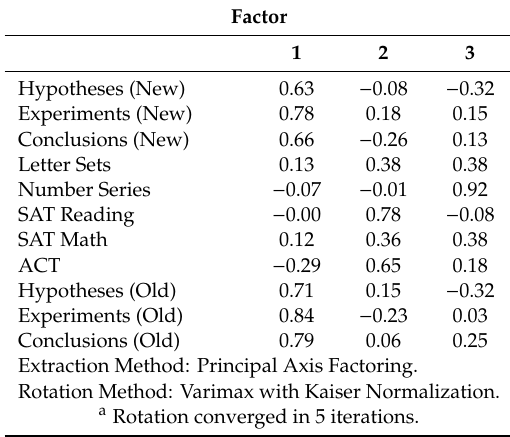
Table 8. Study 1 Rotated Principal-Factor Matrix: Complete Set of Measures a .